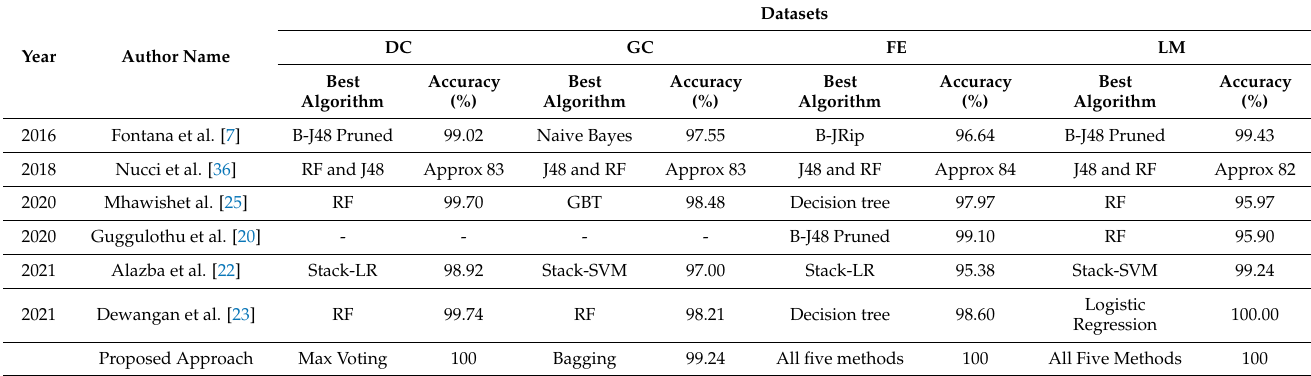
Table 15. Result comparison of our approach with other correlated